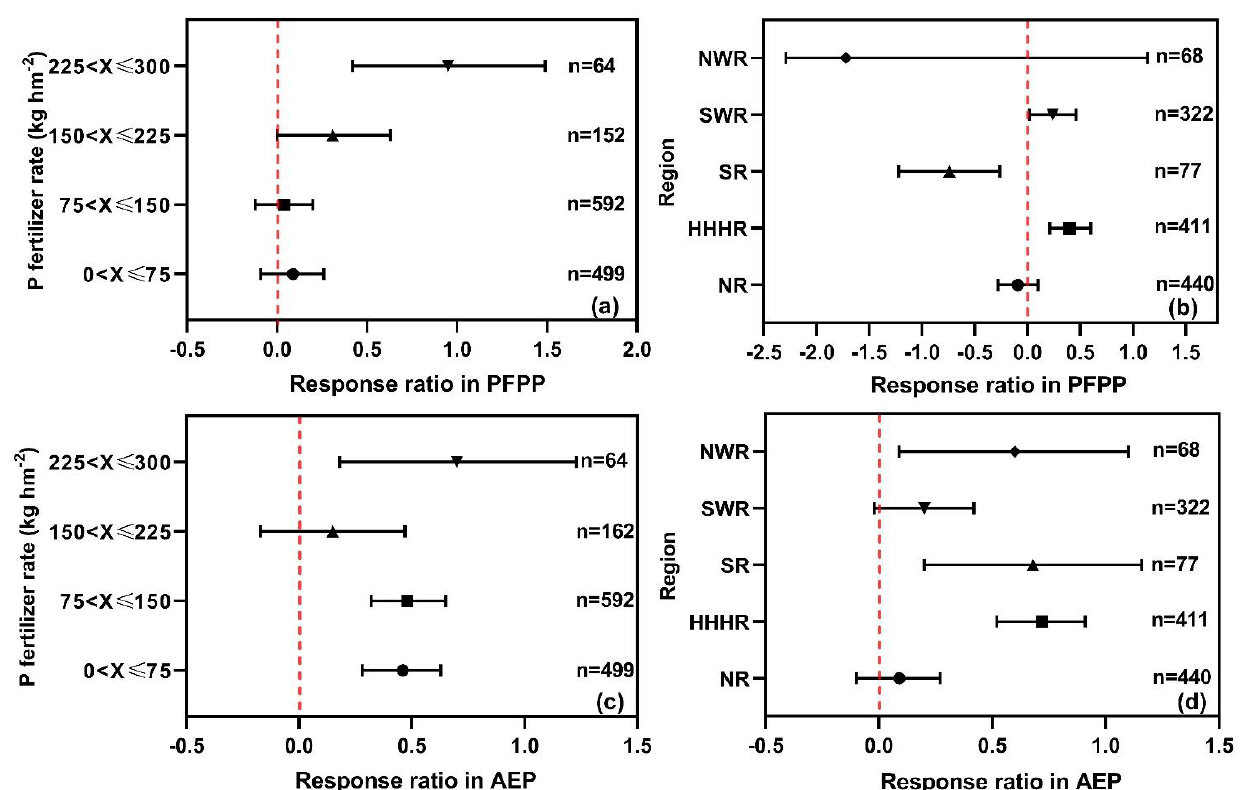
Figure 9. The effects of period (2012 − 2018 versus 2005 − 2011) on maize PFPP and AEP at each P fertilization level ( a , c ), in each region ( b , d ). NR: Northern region; HHHR: Huang-Huai-Hai region; SR: Southern region; SWR: Southwest region; NWR: Northwest region; PFPP: partial factor productivity of P; AEP: agronomic efficiency of P. The error lines indicate the 95th percentile bootstrap confidence intervals, whereas n values indicate the corresponding number of observations (total number of control and treatment values). The PFPP and AEP values of the 2012–2018 period were the treatment values, and the PFPP and AEP values of the 2005–2011 period were the control values.